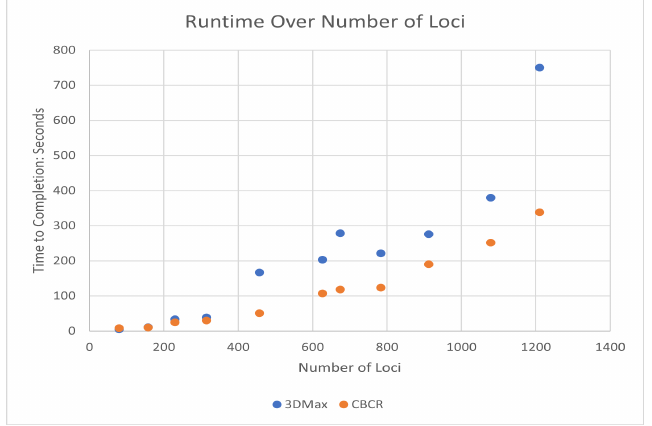
Figure 5. Time comparison between CBCR and 3DMax for various numbers of